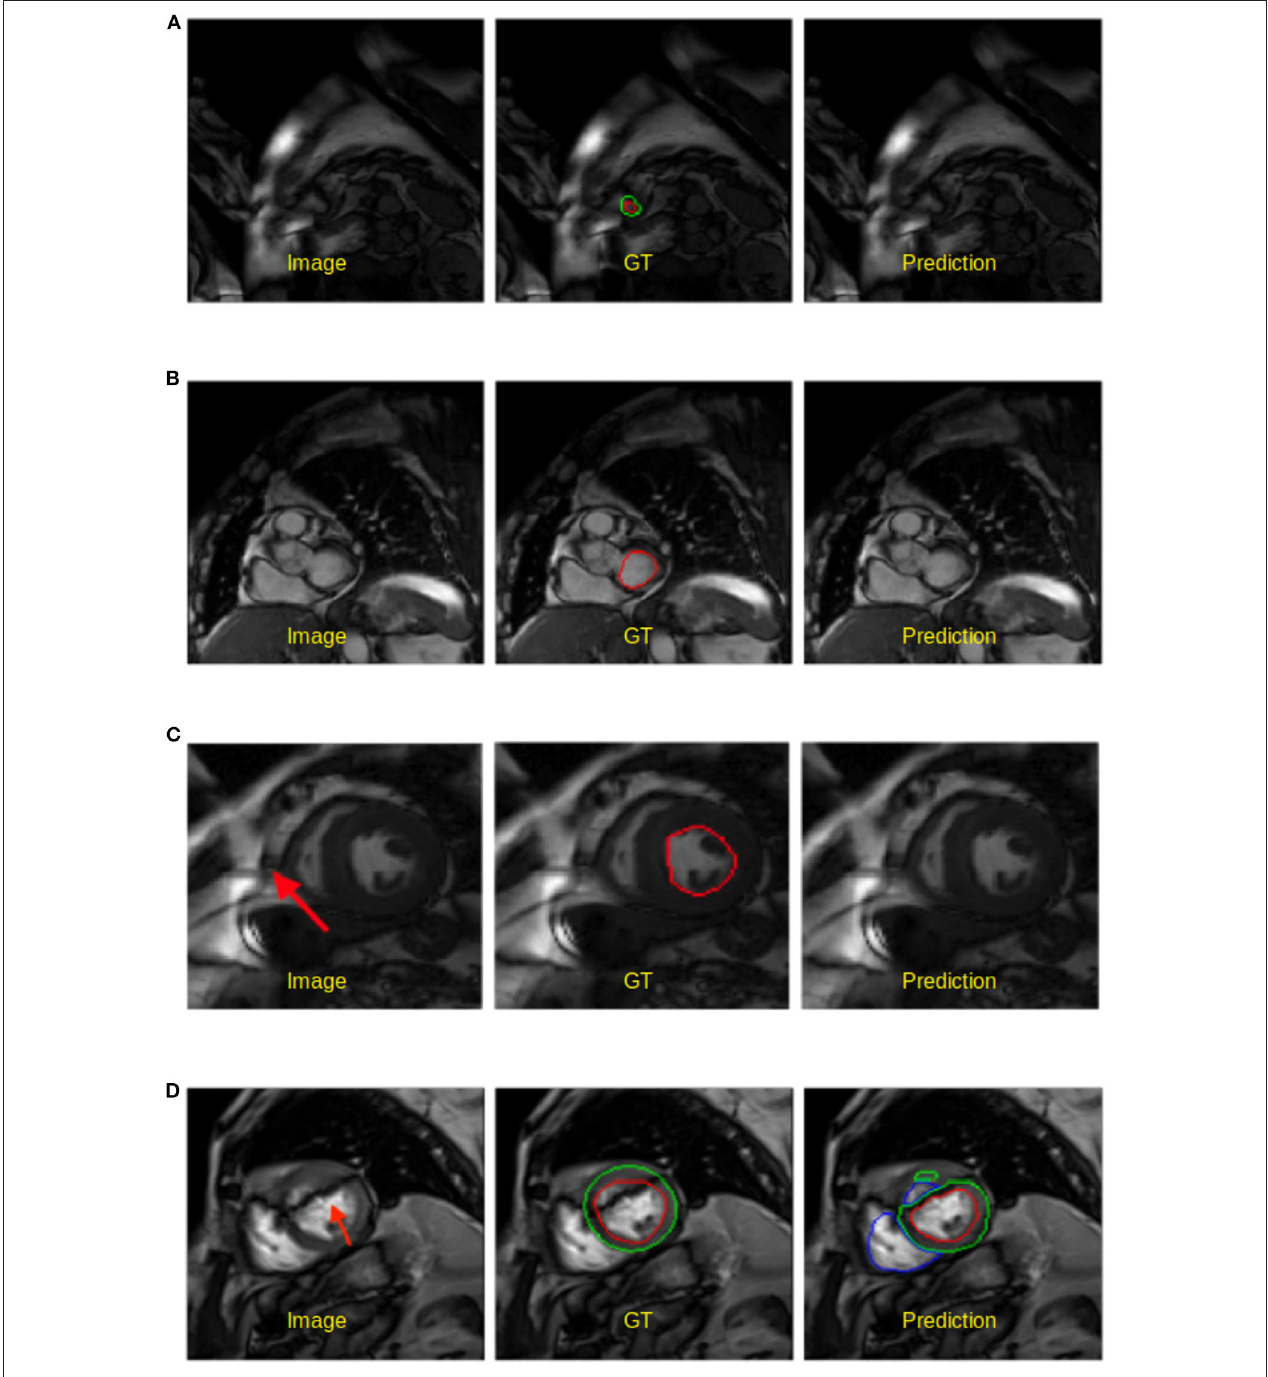
FIGURE 5 | Examples of worst segmentation results found on challenging slices. Left: Image, middle: ground truth (GT), right: prediction from the UKBB model. (A) Failure to predict LV when the apical slice has a very small LV. (B) LV segmentation missing on the basal slice (ES frame). This sample is from the BSCMR-AS dataset where only the LV endocardial annotation is available. (C) Failure to recognize the LV due to a stripe of high-intensity noise around the cardiac chambers in this 1.5T image. This sample is an ES frame image from the BSCMR-AS dataset. (D) Failure to estimate the LV structure when unexpected strong dark artifacts disrupt the shape of the LV in this 3T image. Note that this image is an ED frame image from the BSCMR-AS dataset where RV was not annotated by experts.